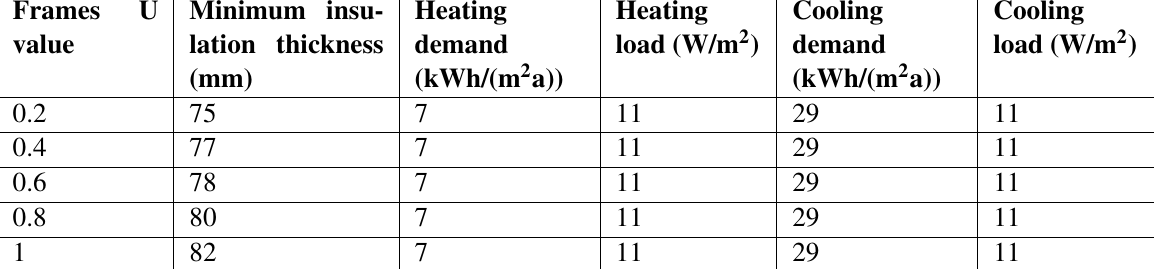
Table 3 Relation between U value of frames and minimum insulation